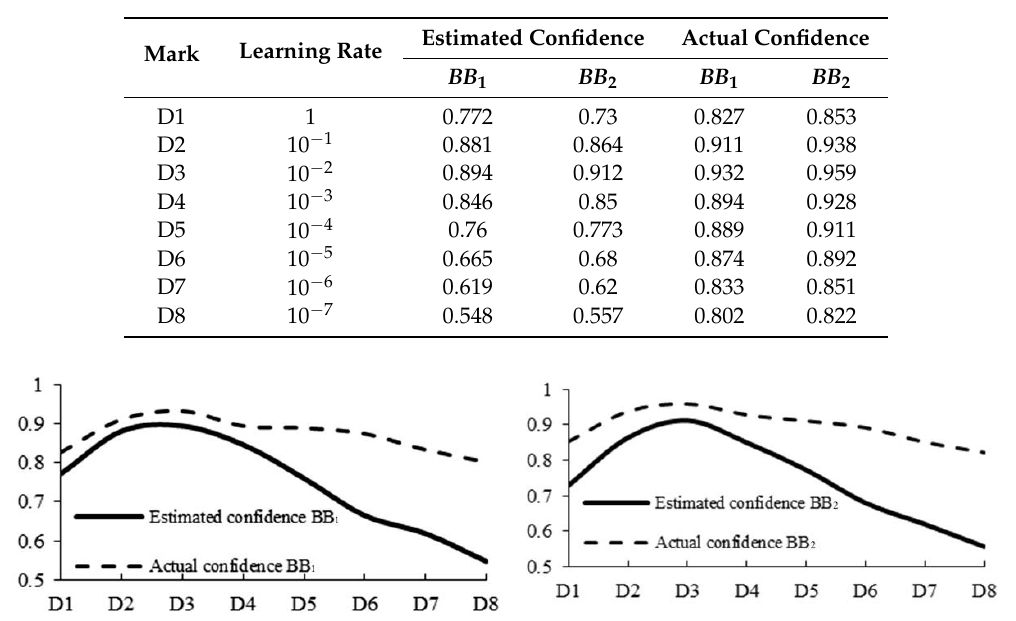
Table 3. Model performance under different learning rates.